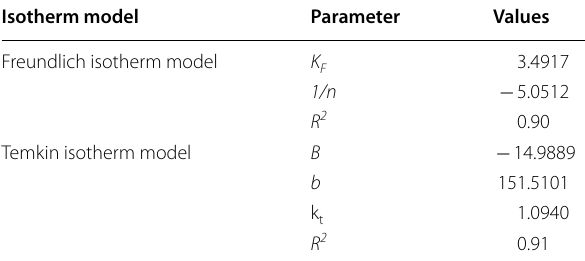
temperature is depicted in Table 5. 1/ n constant recip- rocal implies natural sorption; therefore, the adsorption process is beneficial. The values of n, 1/ n , K F , and R 2 for the current work are also presented in Table 5. Temkin